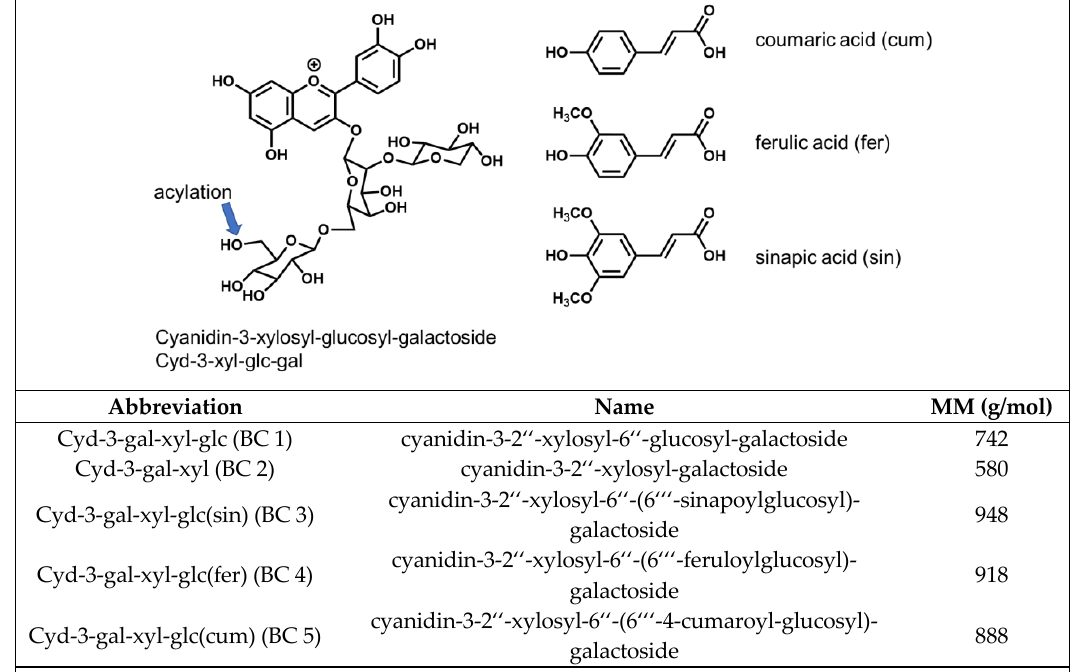
Figure 2. Anthocyanin structures isolated from black carrot according to Gläßgen et al.